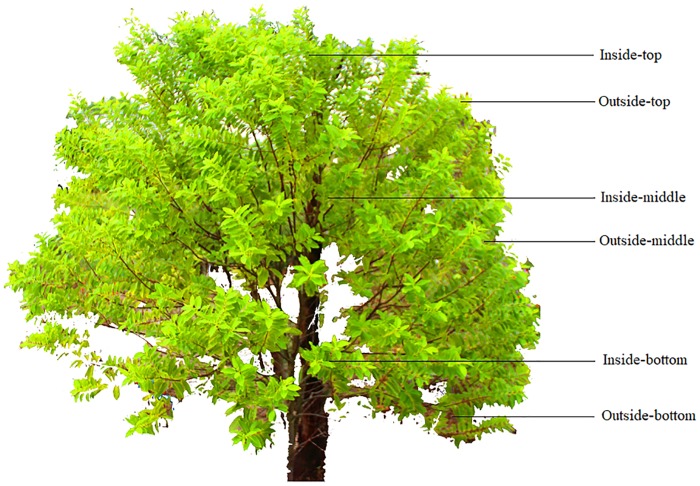
Sampling method.